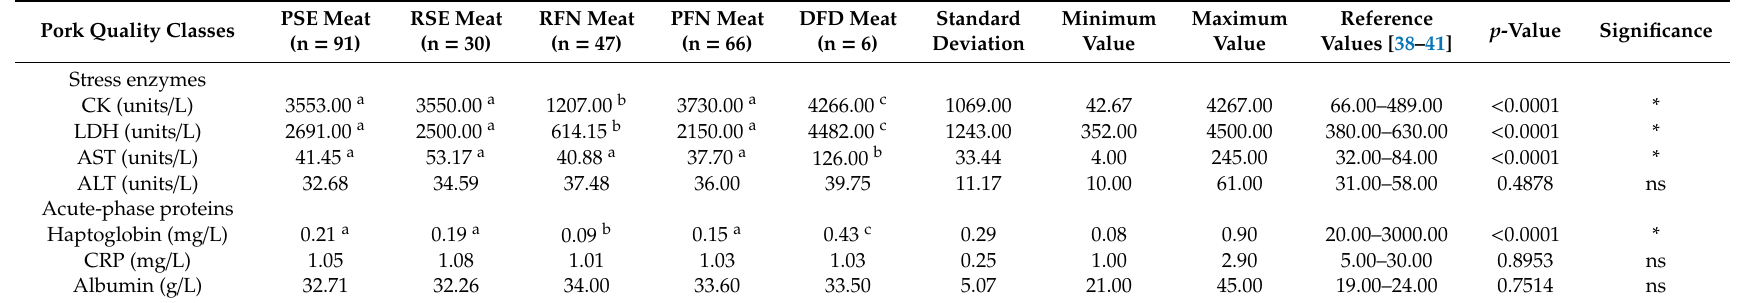
Table 7. Di ff erences of stress enzymes and acute-phase proteins between pork quality classes.